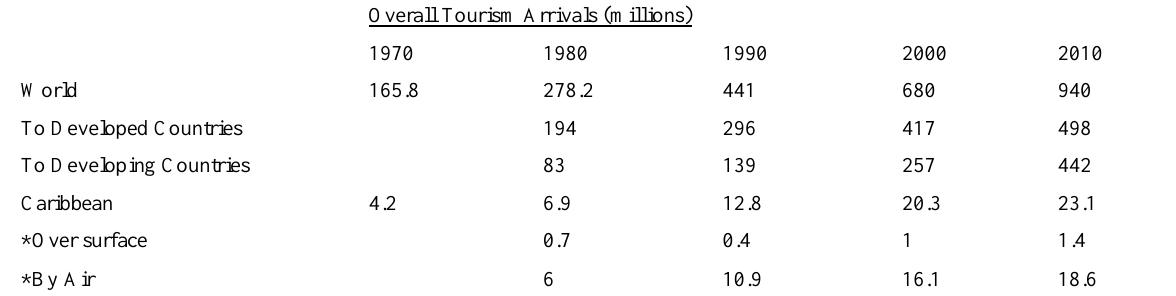
Overall Tourism Arrivals